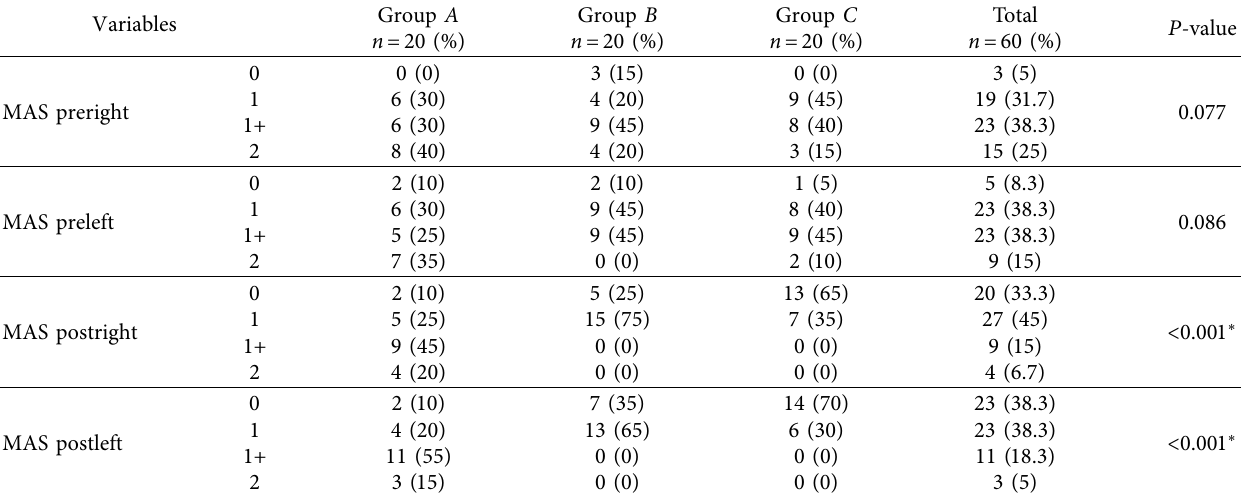
Table 2: Comparison between groups regarding MAS of both right and left knees pre- and post-therapy. Variables